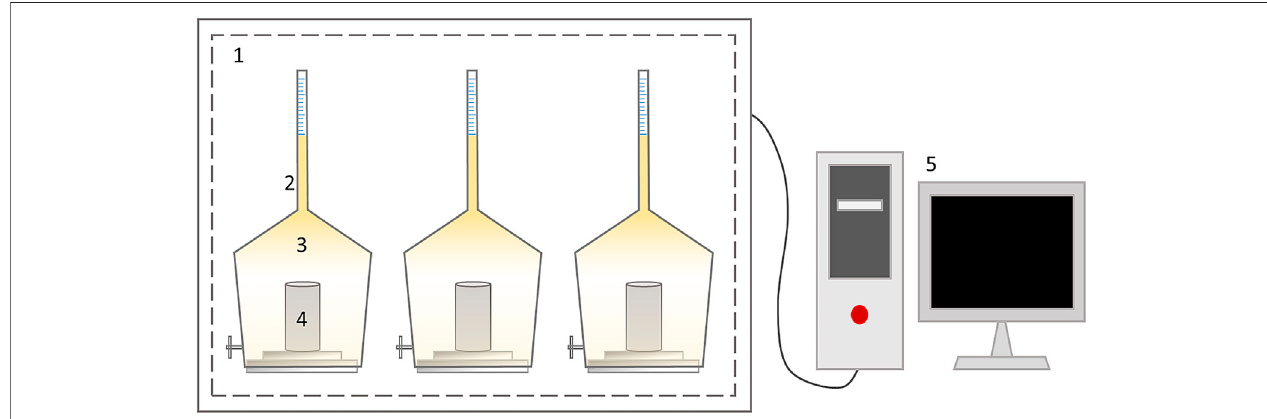
FIGURE 1 | Schematic of the imbibition assembly: (1) temperature control system, (2) imbibition apparatus, (3) oil-displacing agent, (4) core, (5) data entry system.